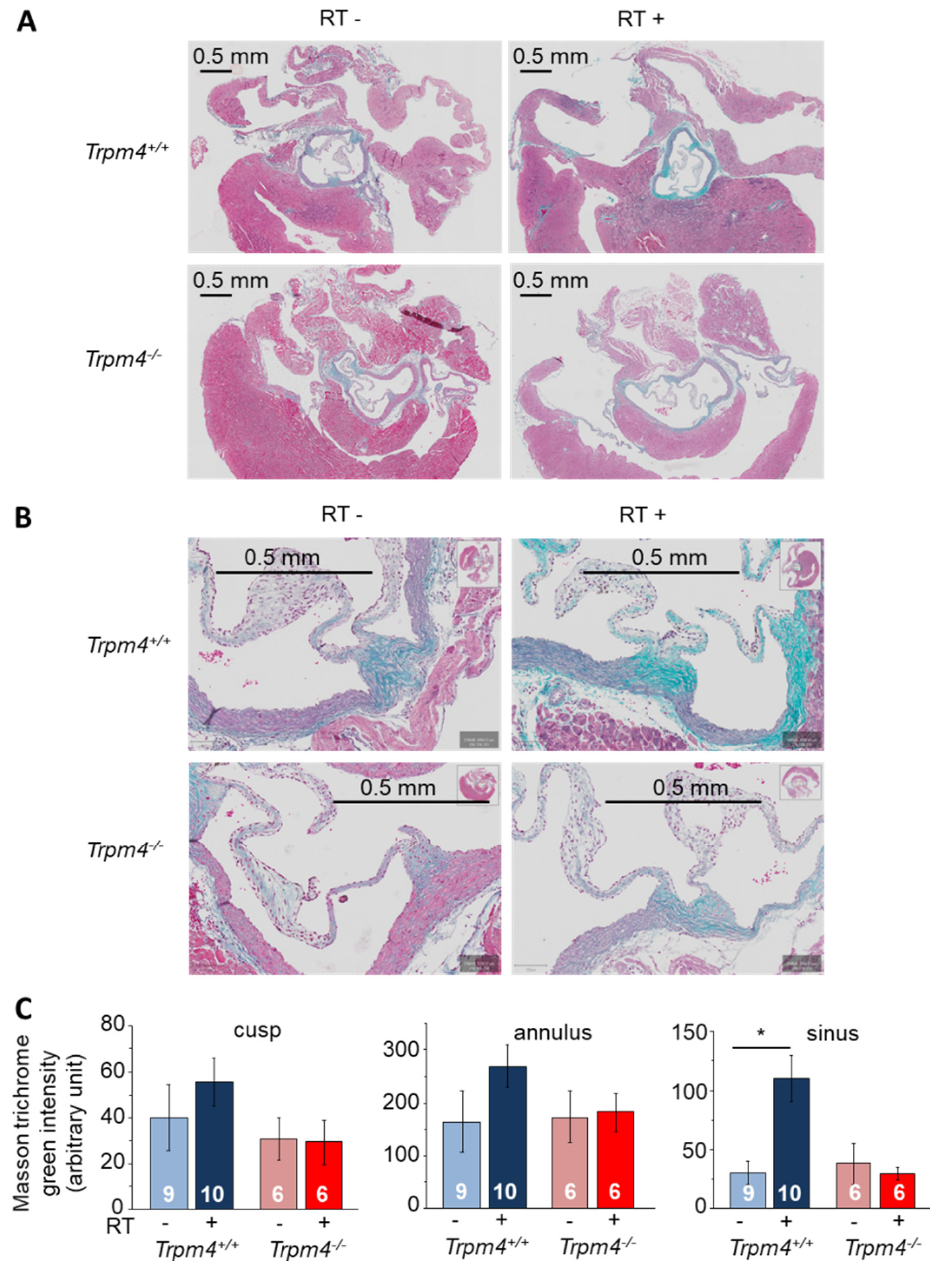
Figure 7. Effect of irradiation on aortic valve fibrosis using Masson trichrome staining. ( A , B ) Histological slices performed at 5 months post-treatment in the transversal axis (3 µ m thickness) of the aortic valve representative for each group, stained with Masson trichrome to reveal fibrosis. Images in A represent the whole transversal section of hearts while images in B represent a magnification of the same hearts in the aortic valve area. ( C ) Valvular green chromaticity intensity after Masson trichrome staining for each group in arbitrary units (see methods for quantification protocol). Data were measured for the cusp ( left histogram ), annulus (middle histogram), and sinus ( right histogram ). Data indicate the mean ± S.E.M. for each group. * indicates a significant difference between groups ( p < 0.05).